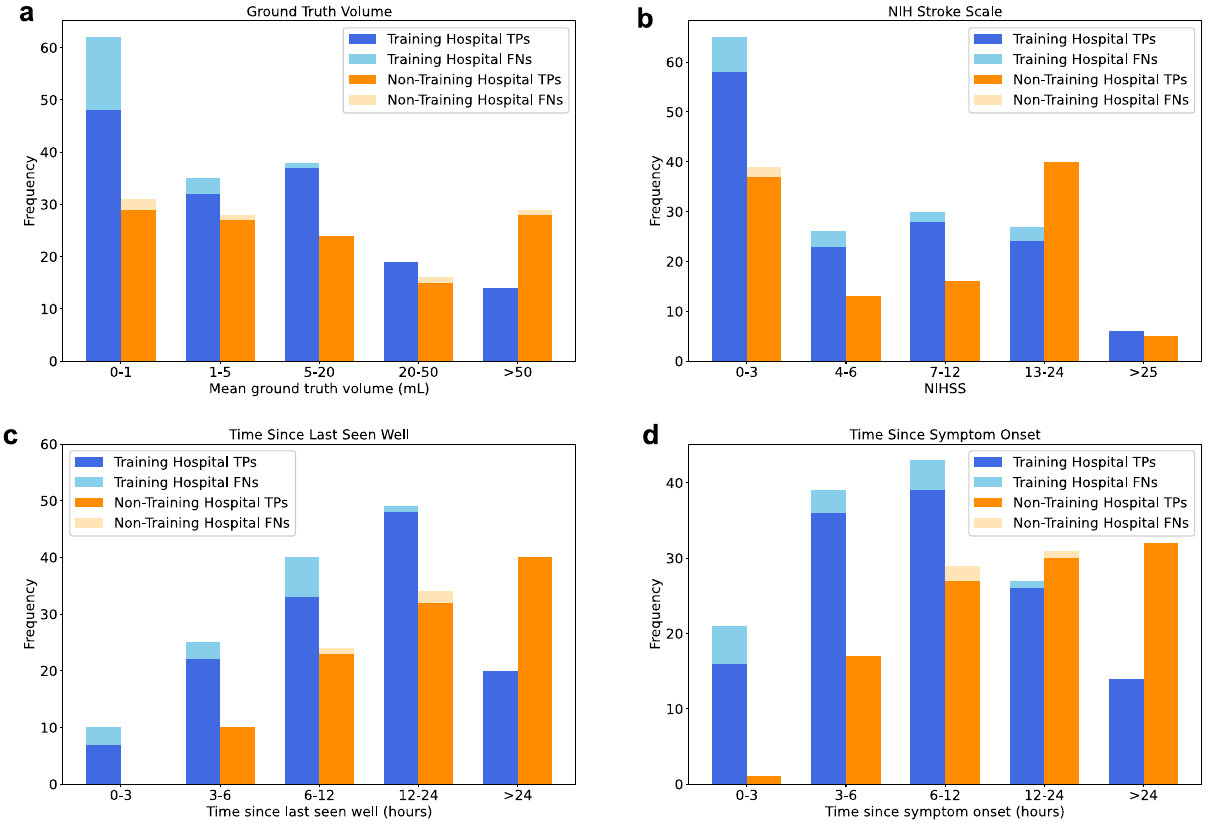
Figure 4. Model performance based on clinical scenario for stroke code test sets: ( a – d ) Histograms demonstrating the number of true positive (TP) and false negative (FN) studies for different ground truth volumes ( a ), NIH Stroke Scales ( b ), time intervals between last seen well and MRI ( c ), and time intervals between symptom onset and MRI ( d ). The images from the false negative studies with ground truth volume > 1 mL are included in Supplementary Fig. S9. As an example of the time intervals, a patient who presents at 8 am having gone to sleep without symptoms at 10 pm and woken with symptoms at 6 am will have time from last seen well of 10 h and time from symptom onset of 2 h.